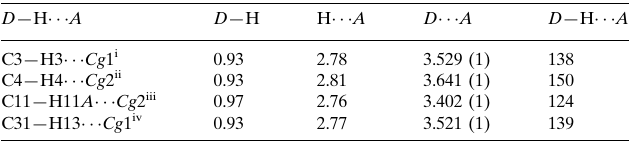
Hydrogen-bond geometry (A˚ , (cid:1)